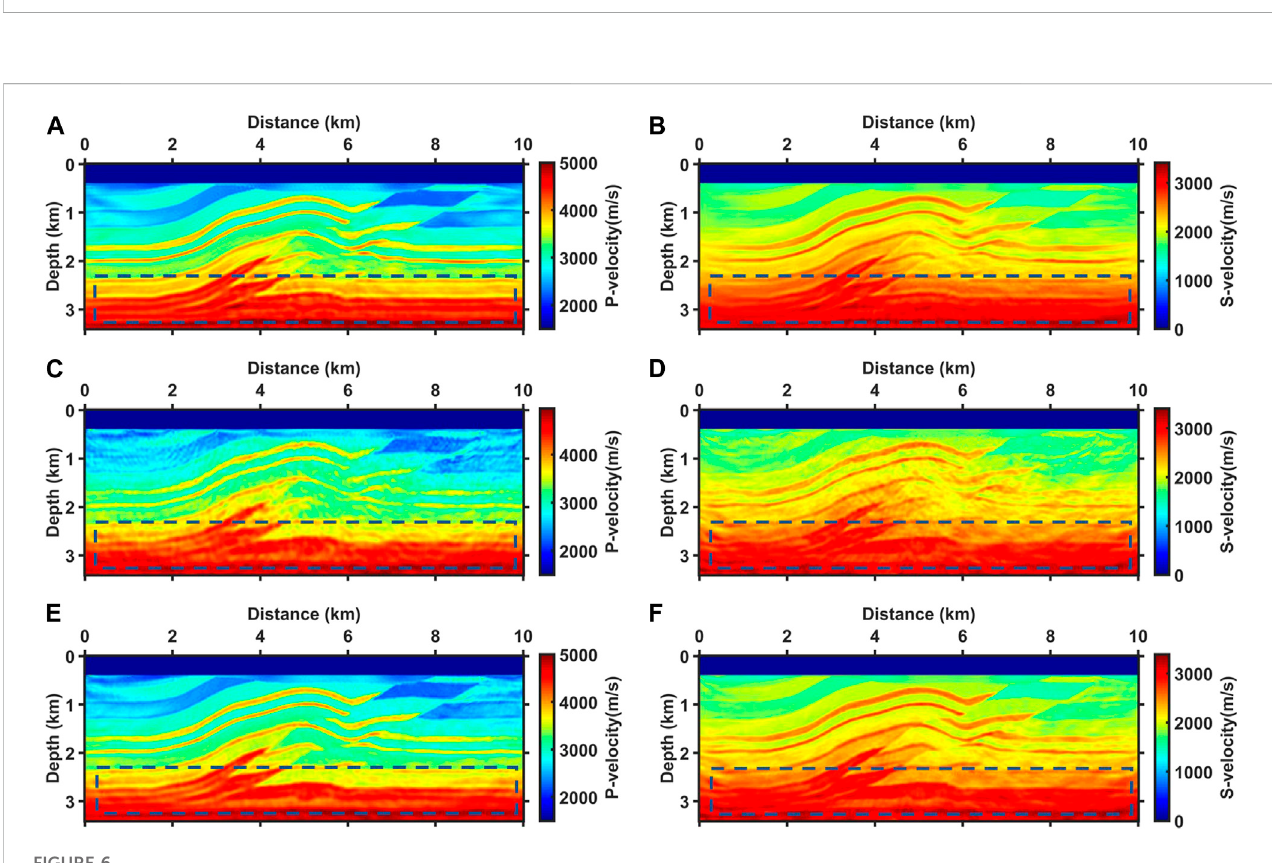
The P-wave velocity (A,C,E) and S-wave velocity (B,D,F) inversion results. (A,B) are results for towed streamer data alone, (C,D) are results for OBS data alone, (E,F) are results for joint towed streamer and OBS